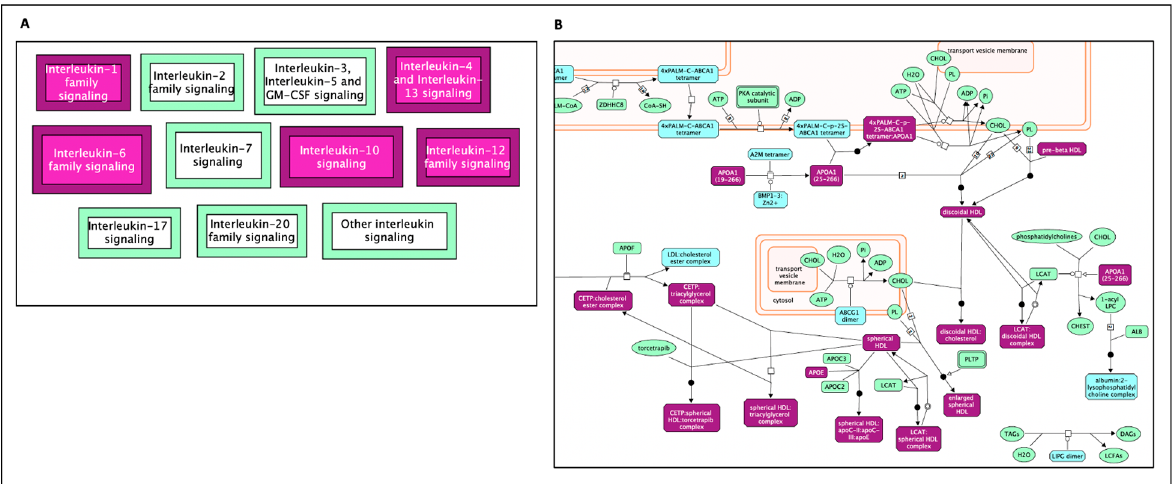
Figure 4. Enriched pathway analysis. The entities colored purple are hits within the positive gene list. Proteins are rectangles whereas elongated hexagons are complexes. ( A ) Generic transcription pathway. ( B ) TP53 regulates the transcription of death receptors and ligands.